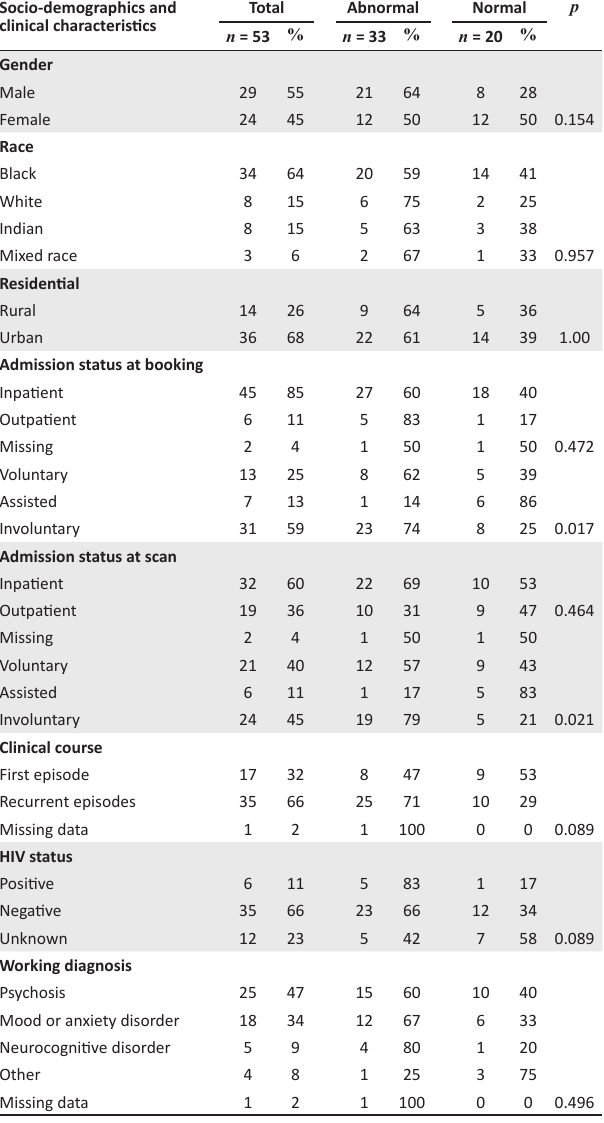
TABLE 1: Socio-demographic and clinical characteristics of patients according to magnetic resonance imaging scan result. Socio-demographics and clinical characteristics